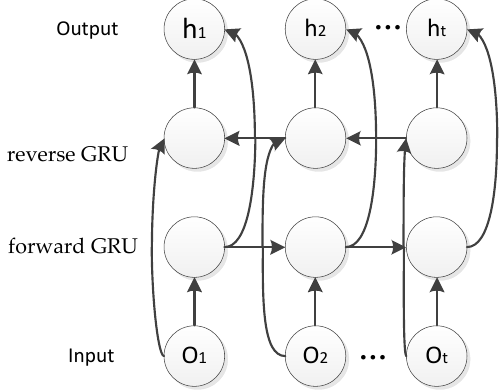
Figure 3. BiGRU Network Layer.